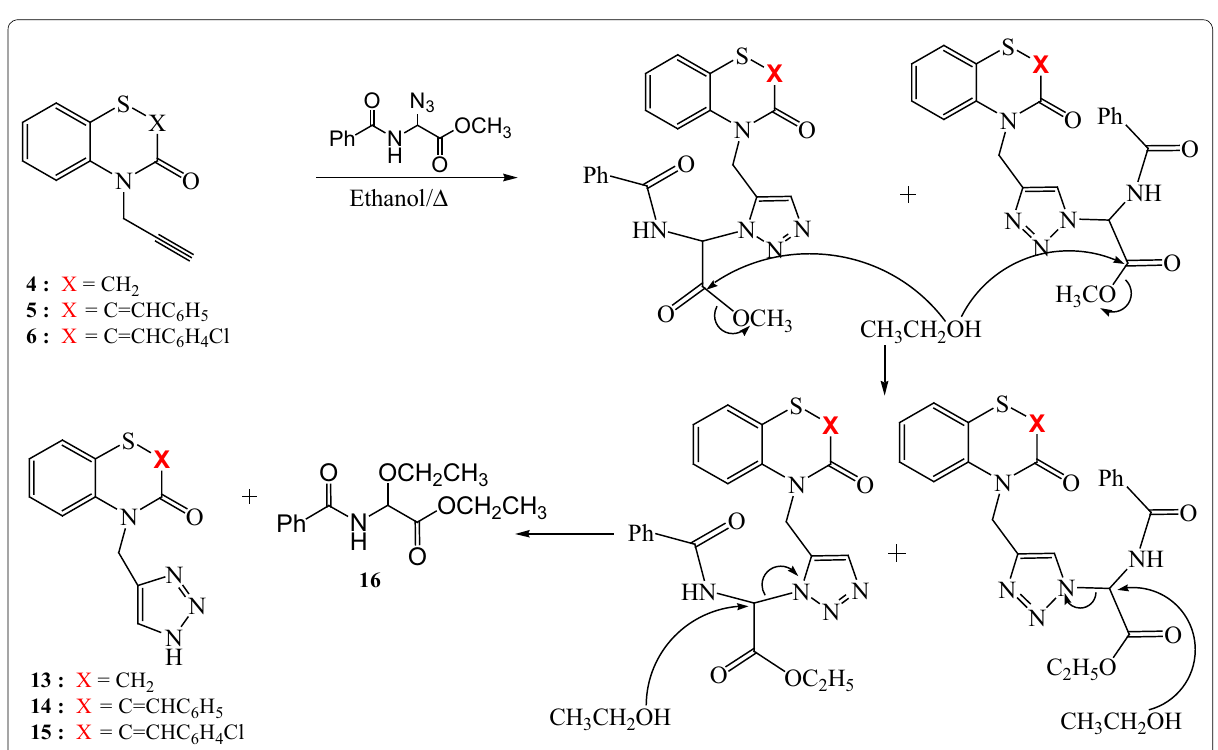
Scheme 4 Proposed mechanism for the formation of 1H-4-substituted 1,2,3-triazoles 13 –